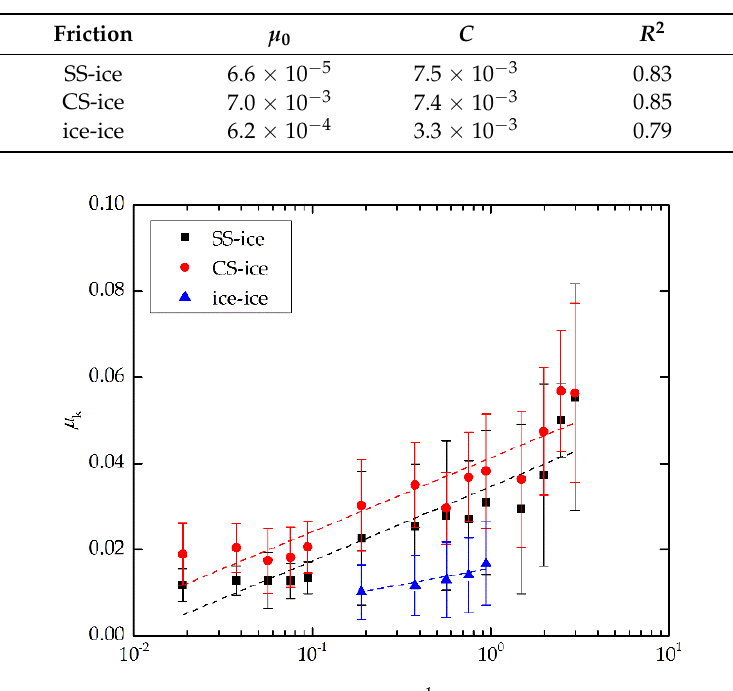
Figure 12. The velocity dependence of μ k . The colored points are the experimental data, and the colored dashed lines are trends fitted based on Equation (4).